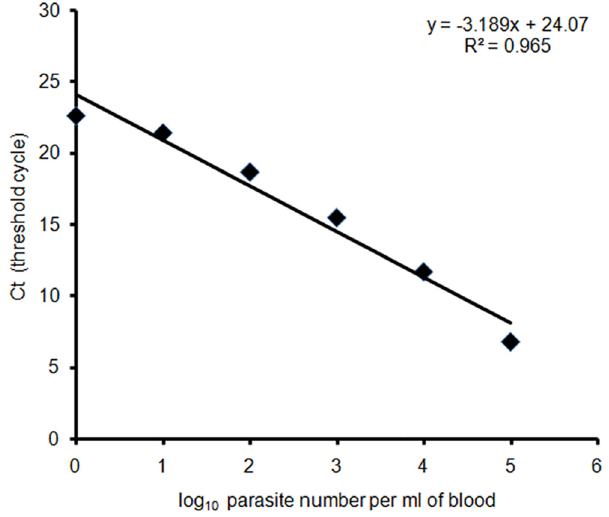
Fig 1. Standard curve for quantification of Leishmania parasites by real-time PCR. The standard curve was obtained by amplification of Leishmania DNA from 10 5 to 1 parasites. Linear regression analysis rendered the equation y = -3.189x+24.07 (R 2 = 0.965). Correlation of disease manifestations with parasite